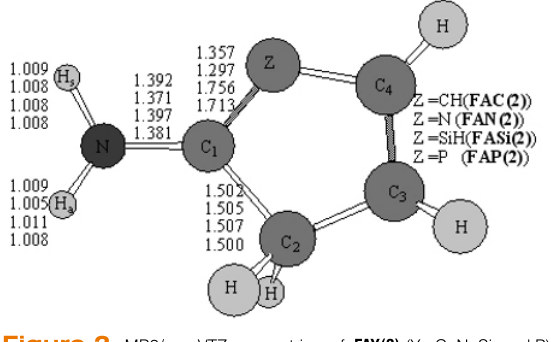
Figure 3. MP2/cc-pVTZ geometries of FAY(3) (Y=C, N, Si, and P) with the bond lengths in